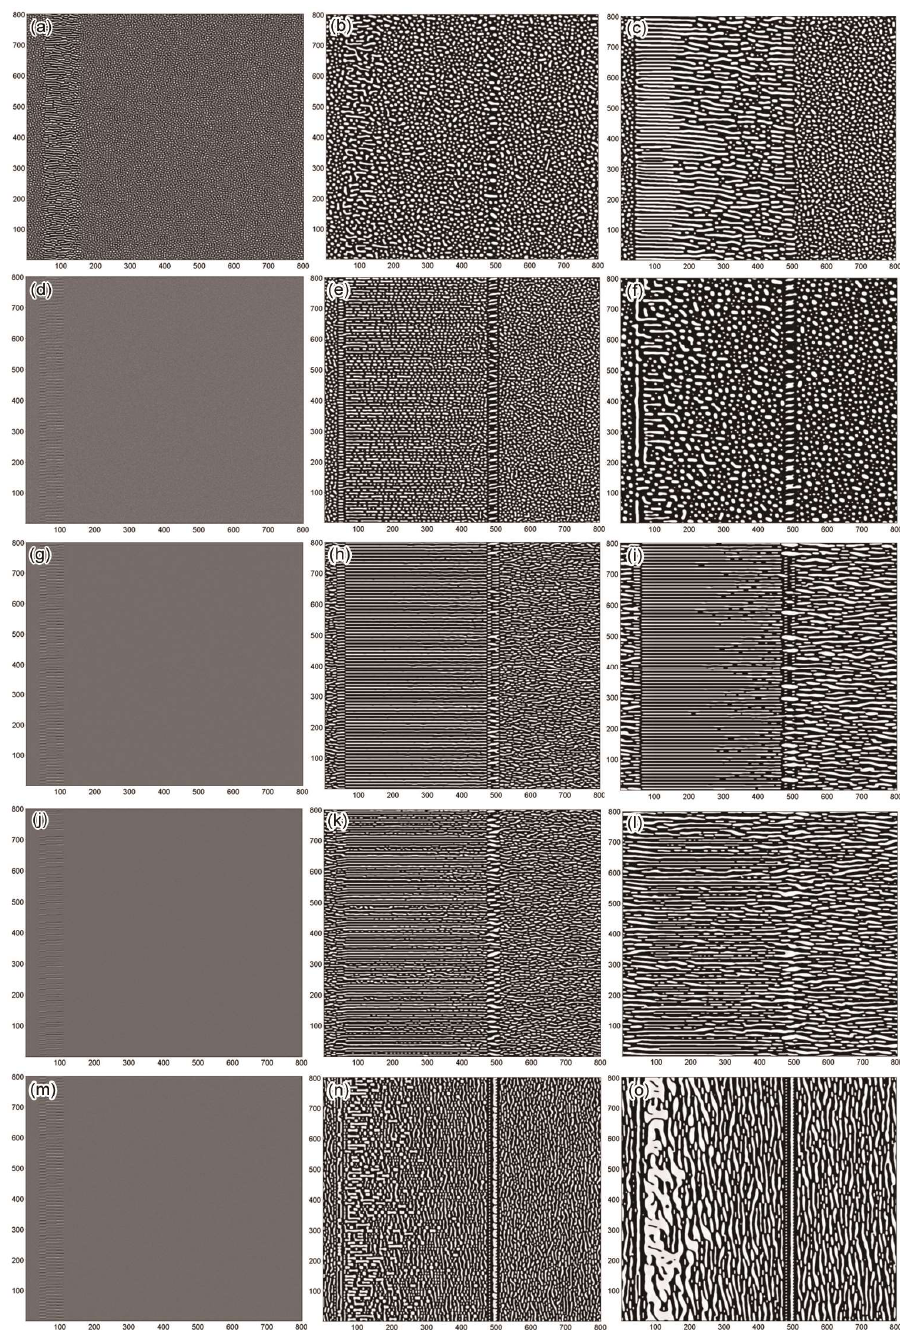
Figure 6. Time sequence of snapshots for the spinodal decomposition under different conditions.